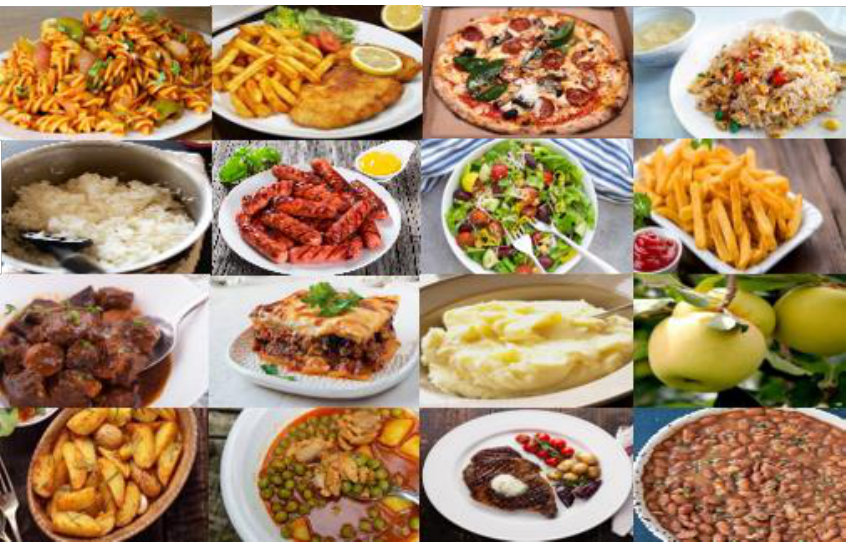
Figure 2. Examples of images used for training the CNN model.